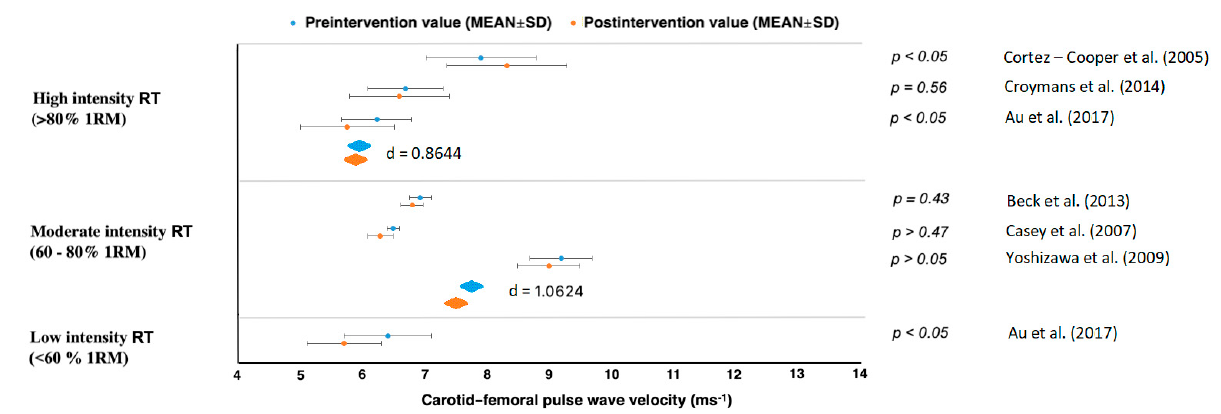
Figure 2. Carotid–femoral pulse wave velocity changes.